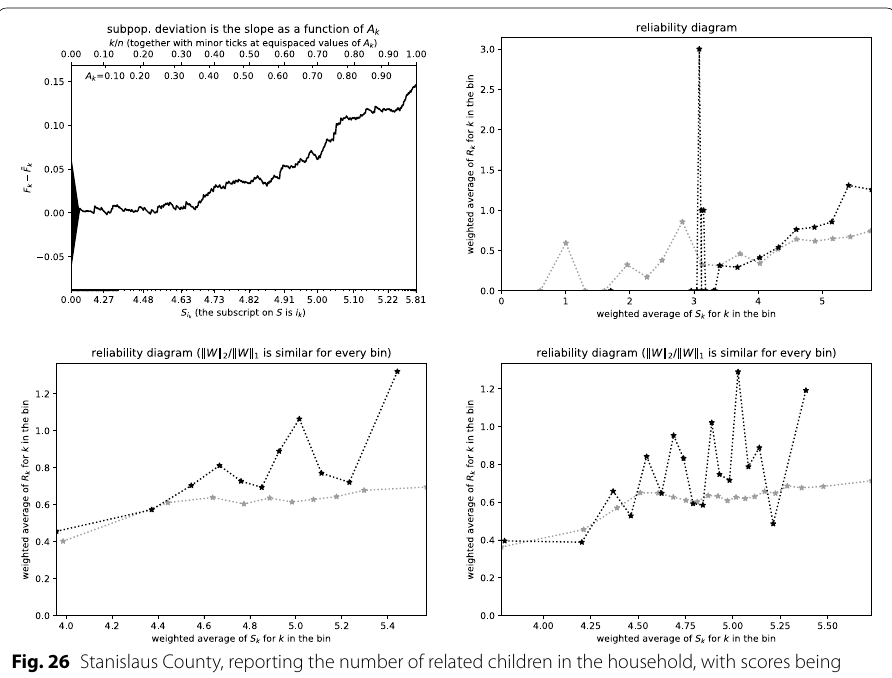
Fig. 26 Stanislaus County, reporting the number of related children in the household, with scores being log 10 of the adjusted household income; n = 1624; Kuiper’s statistic is 0.1489 /σ = 4.500 , Kolmogorov’s and Smirnov’s is 0.1467 /σ = 4.433 . The reliability diagrams are all commensurate with each other, but that is clear only after careful comparison of them all. Making sense of the reliability diagrams in this case would seem to require generating multiple plots, with several different numbers of bins. The scalar summary statistics have little trouble detecting statistically significant deviation